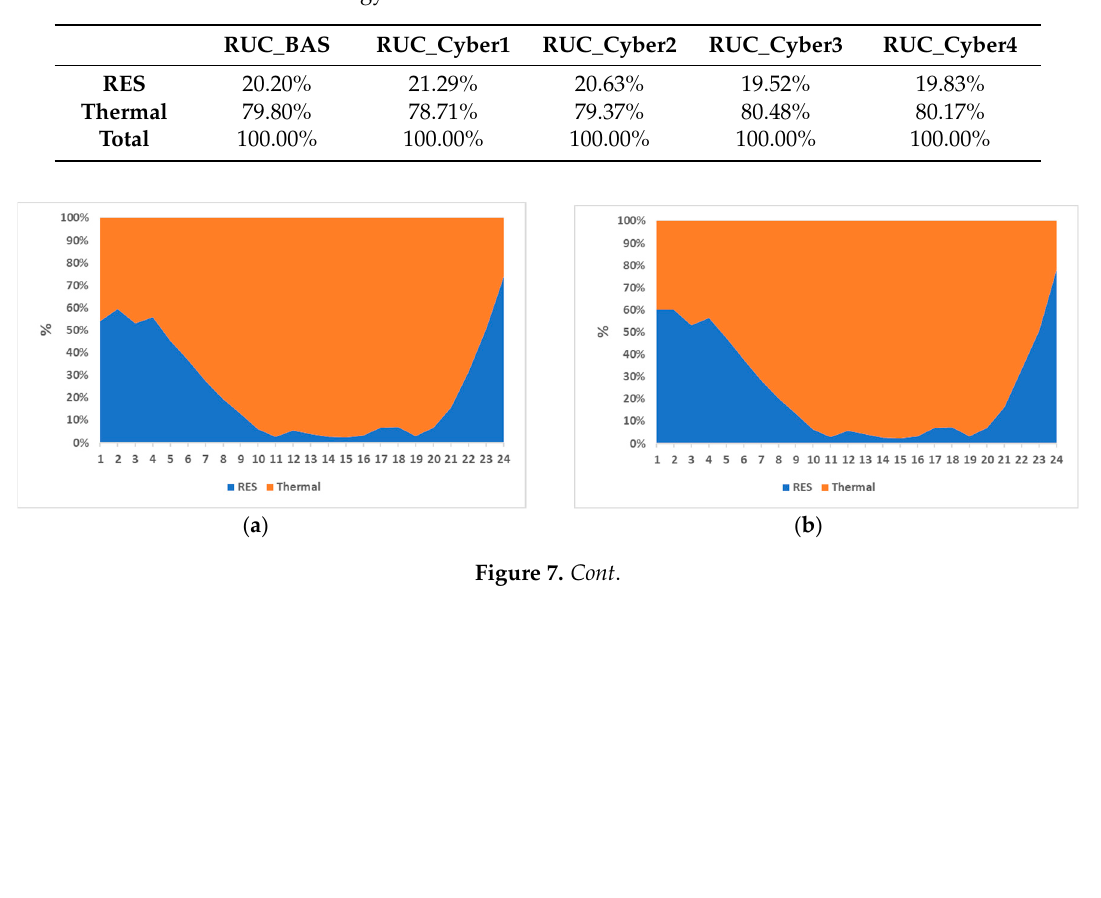
Figure 6. Evolution of hourly energy mix of the examined typical day for the RUC_BAS scenario. 413 Table 3. Energy mix for different scenarios with the RUC model.